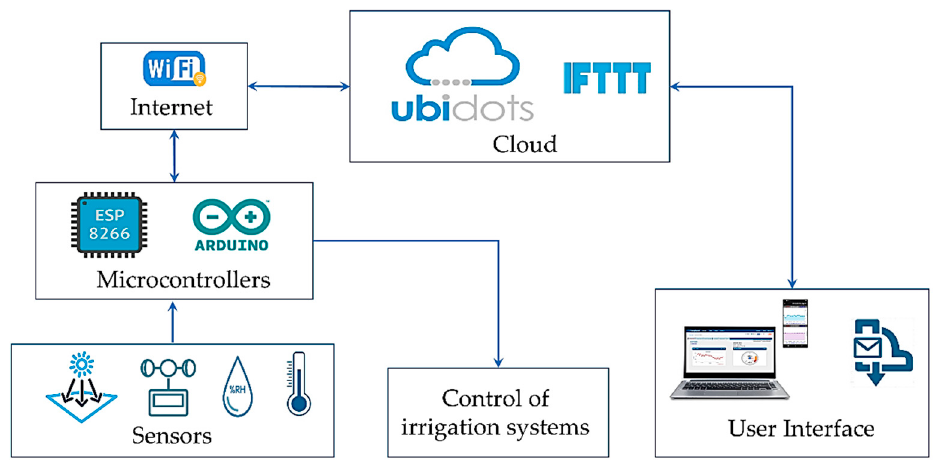
Figure 5. The main components of the cloud-based IoT platform, which was used to real-time monitor the meteorological variables in and control the irrigation water scheduling of the irrigation sys- tems.